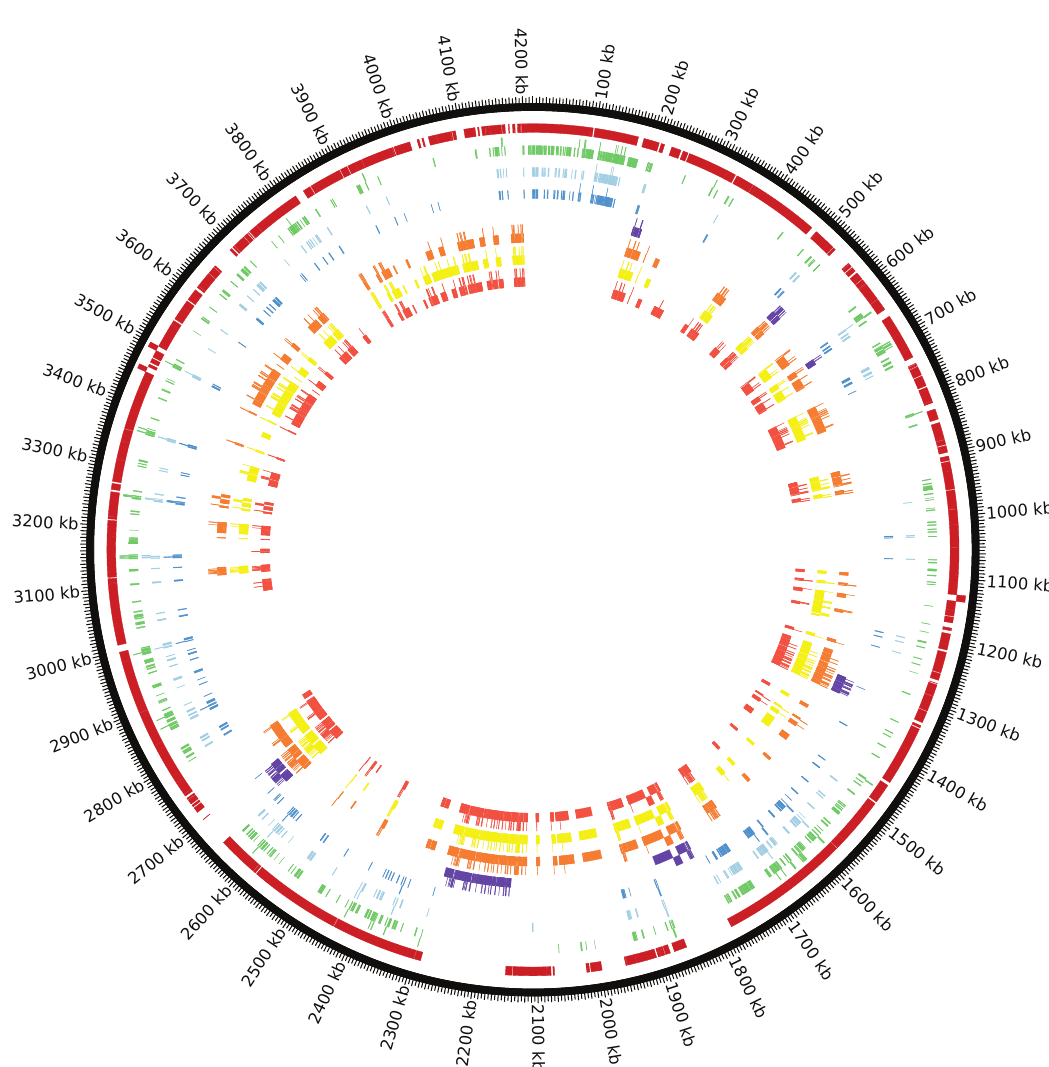
Figure2.Thereareeighttracksmappedtothe B.subtilis referencegenomeinthisCircosfigure. Goingfromthe outsidetotheinside:track1)coreregions(darkred),2)Minibacillusgenes(green),3)Koo etal . 8 essentialgenes(light blue), 4) Kobayashi et al . 7 essential genes (medium blue), 5) deleted genes in strain delta 6 (dark blue), 6) deleted genes in strain IIG-Bs27-47-24 (orange), 7) deleted genes in strain PG10 (yellow), and 8) deleted genes in strain PS38